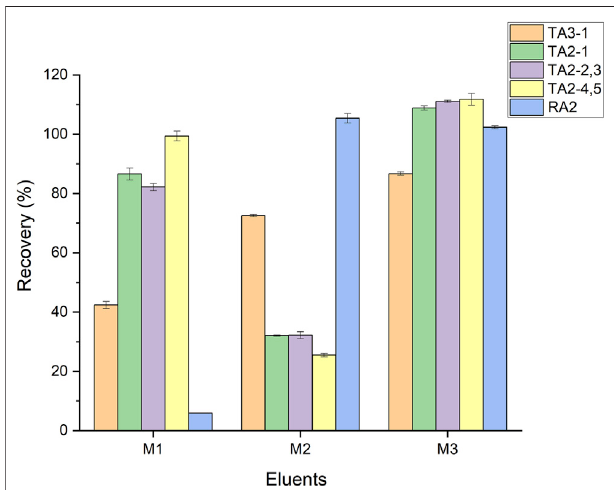
FIGURE4| Comparison ofthecascade elutionand othersimplemodes of SPE procedures. M1, M2, and M3 means methanol, 0.5% FA in 20% methanol, water, and cascade elution (methanol and 0.5% FA in 20% methanol water), respectively.